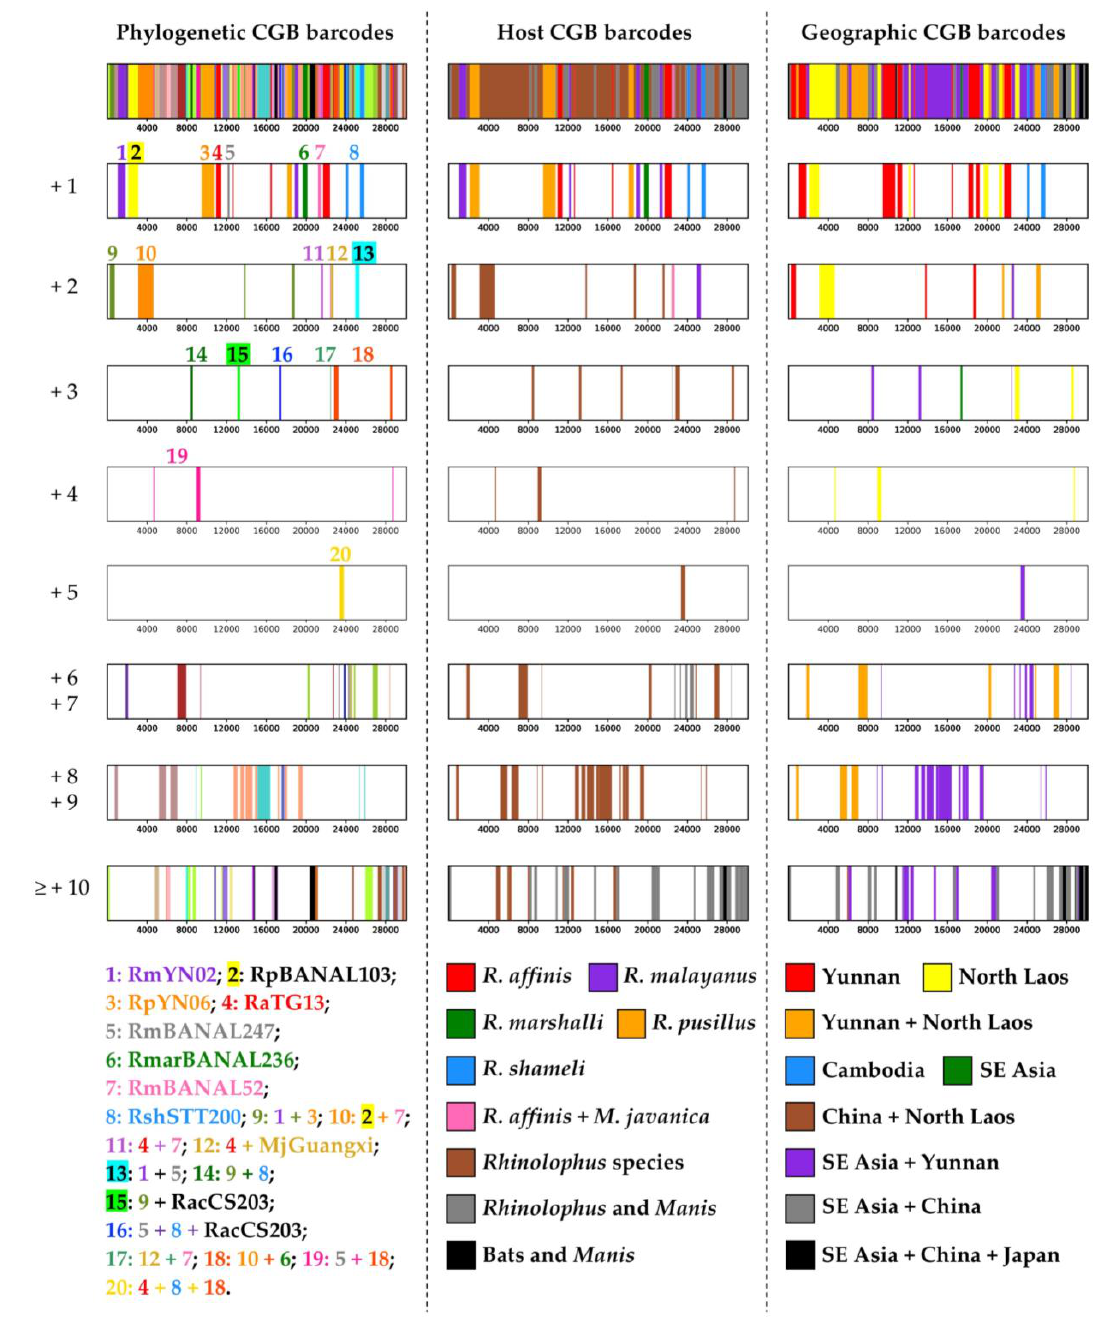
Figure 5. Coloured genomic bootstrap (CGB) barcodes constructed for the common ancestor of SARS-CoV-2. At the left part of the figure are shown phylogenetic CGB barcodes, in which the best phylogenetic signals (i.e., BBC bipartitions including the fewest number of closely-related viruses) are represented by different colours. To facilitate interpretation, we have also shown versions reduced to the bipartition categories +1 (n = 8 bipartitions including SARS-CoV-2 and another virus), +2 (n = 5 bipartitions including SARS-CoV-2 and two other viruses), +3 (n = 5), +4 (n = 1), +5 (n = 1), +6 and +7 (n = 8), +8 and +9 (n = 6), and all bipartitions uniting SARS-CoV-2 sequences with at least 10 other viruses (n = 18). The bat and pangolin sarbecoviruses included in the 20 smallest bipartitions (categories +1 to +5) are detailed at the bottom. Similarly, the full and reduced versions of host and geographic CGB barcodes are shown in the middle and right parts of the figure. The colour codes used for host taxa and geographic areas are provided at the bottom.